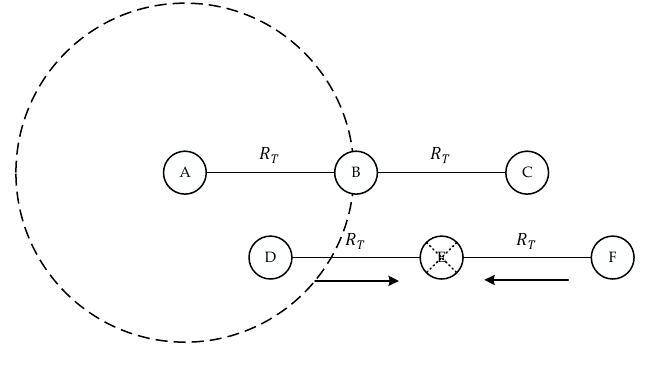
Figure 5. An example of collision.